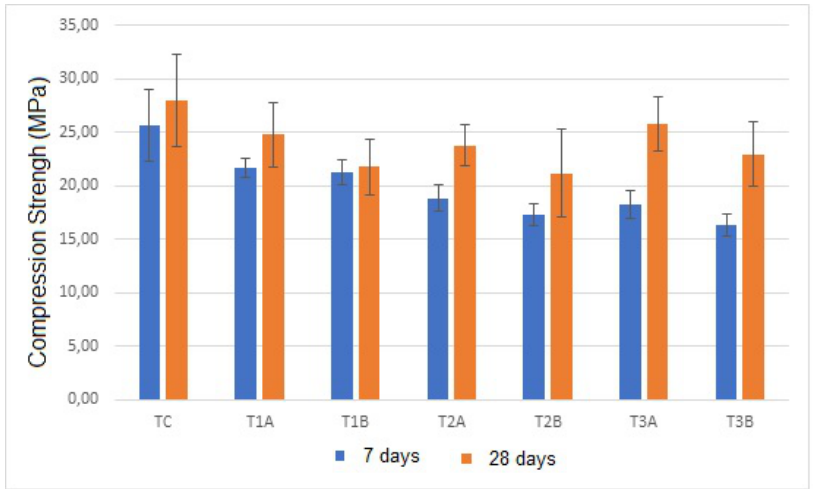
Figure 7. Compression strength of samples at 7 days and 28